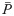
Statistics of conformation capture data.A. Average encounter frequency map of two 5C replica spanning ≈1Mbp genomic region containing two Topologically Associating Domain (TAD) D (monomers 1–106) and TAD E (monomers 107–307) [3], where the map was coarse-grained into 307 monomers of size 3kbp [5]. B. Schematic representation of a polymer model with randomly connected monomers. C. Empirical encounter probability Pn, for monomer n plotted with respect to the genomic distance d [monomer units], reveals long-range interactions (localized peaks). Pn are fitted with functions Ad−β, where β is the decay exponent and A the normalization factor. For the mean encounter probability P¯, the value of the parameters are A = 0.08 and β = 0.77 (thick red curve). D. Distribution of the βn exponents (n = 1‥307) (blue dots): Monomers m24, m100, m162 (red square dots) with β24 = 0.22, β100 = 0.46, and β162 = 0.33, respectively, accounts for high peaks (first and last), while the middle one corresponds to the boundary between TADs. E. Encounter probability Pn for monomers n = 24, 100, and 162, corresponding to local minima shown in box D.